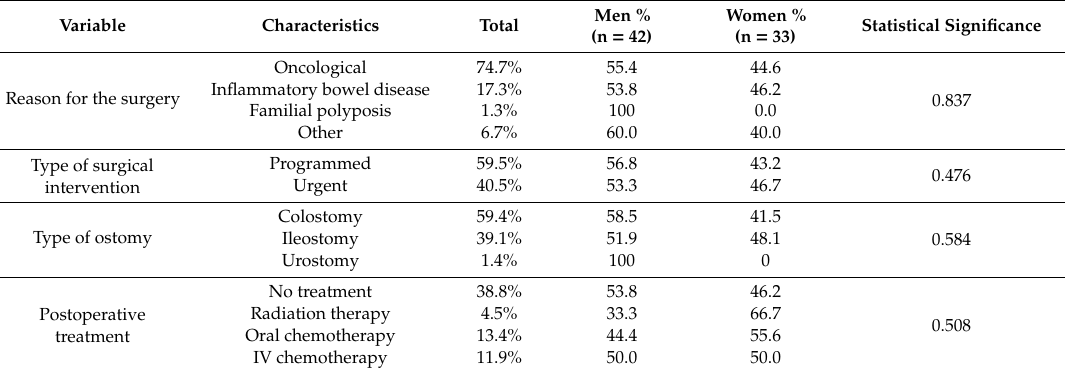
Table 3. Patients clinical characteristics.